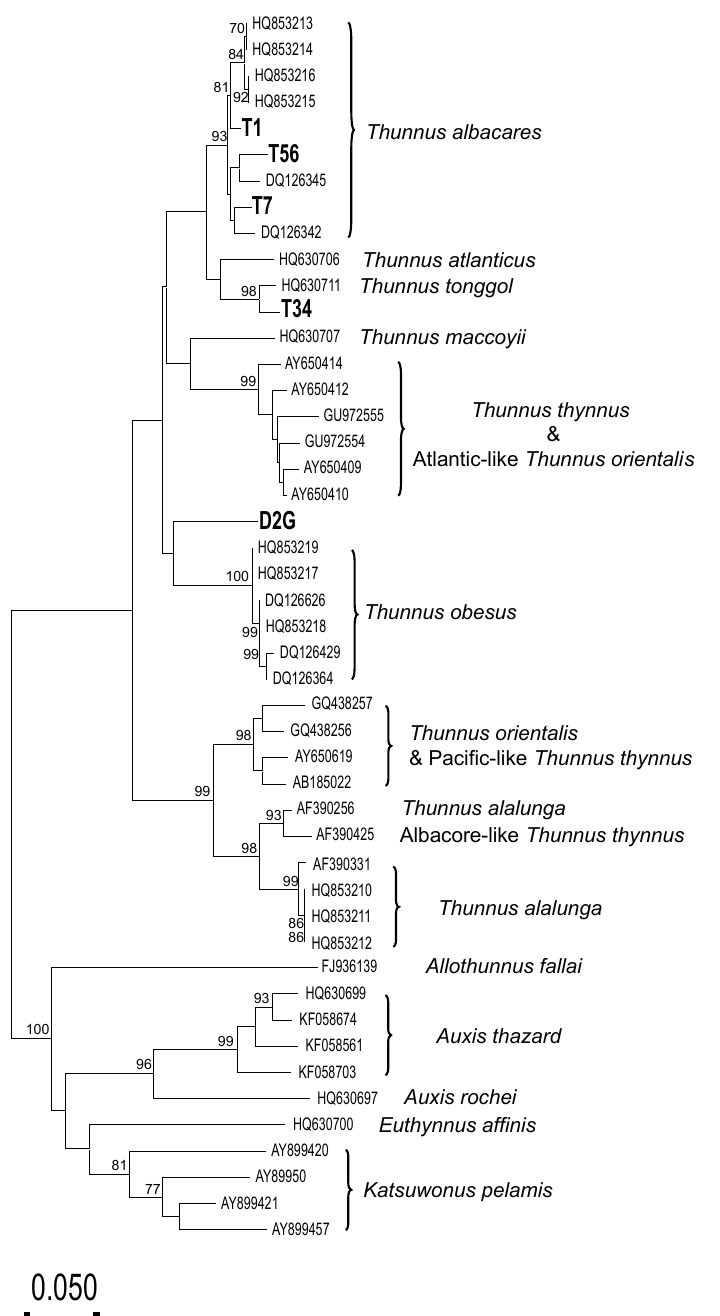
Figure 2. Neighbor-joining (NJ) tree of the K2P model of 47 taxa inferred from 256 bp of mitochondrial control region (CR) sequences with 1000 bootstrapping replicates. Each terminal is labeled with the GenBank accession number or sample code. Bootstrapping values ≥ 70 are indicated on the respective branches.